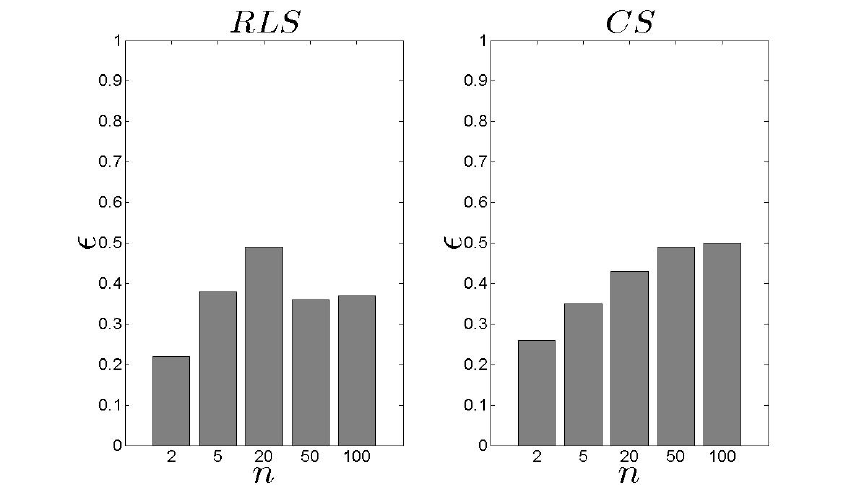
Figure 9. RLS and CS results for the (cid:101) metric ( |F| =